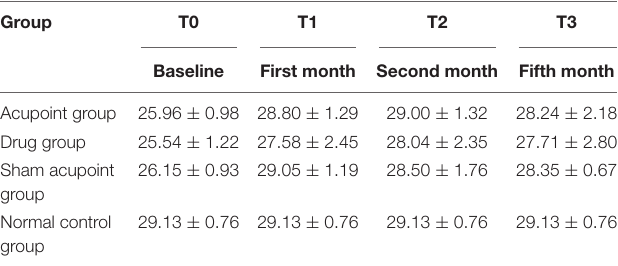
TABLE 4 | Mini-mental state examination (MMSE) scores in four groups at different time